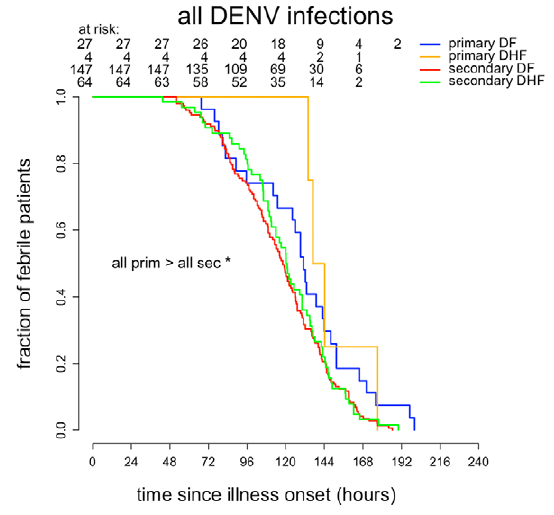
Figure 5. Fever clearance time. Kaplan-Meyer survival analysis of fever clearance time in all viremic patients. Two patients afebrile at enrolment developed fever soon after and for the purposes of analysis were considered febrile at the time of